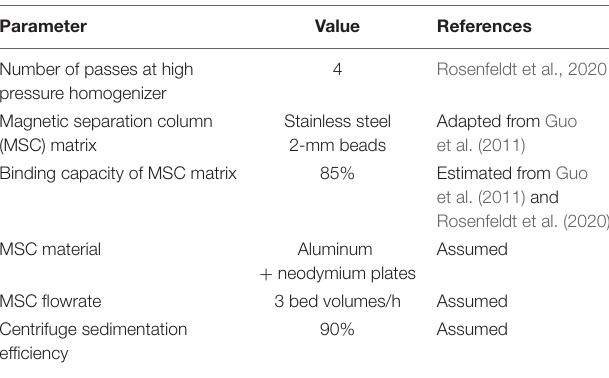
TABLE 2 | Parameters considered for simulation–downstream section (base